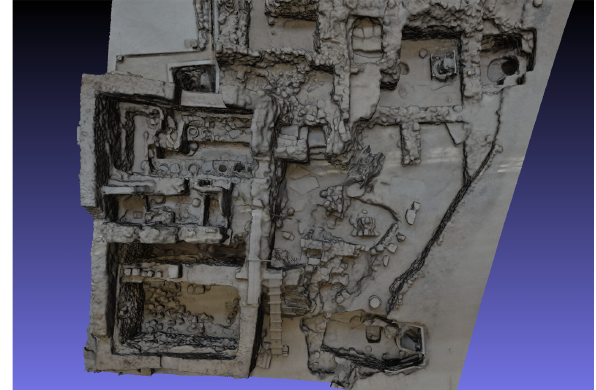
Figure 8: Image-based 3D model of Complex Beta.